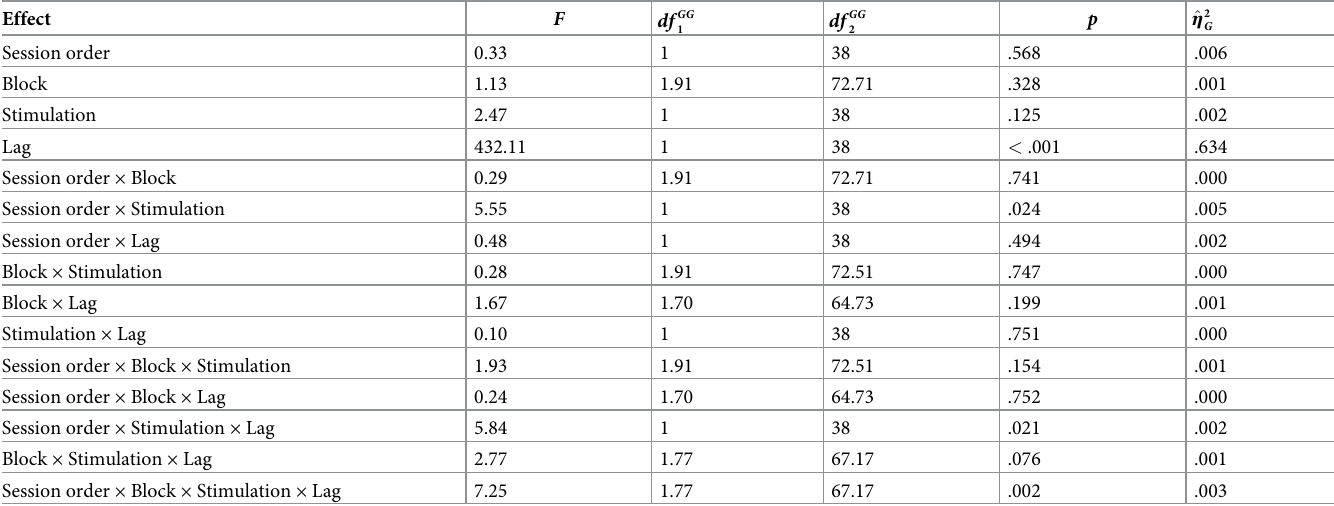
Table 2. Repeated measures ANOVA on T2|T1 accuracy.